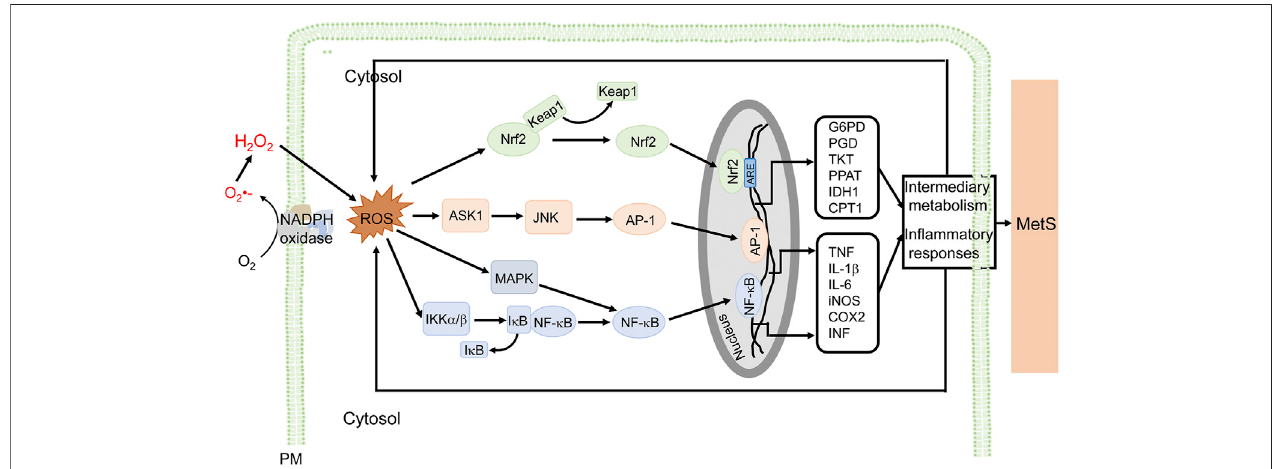
FIGURE 3 | NADPH oxidase-derived ROS signaling and cellular effects in MetS. ROS derived from NADPH oxidases are involved in the in fl ammatory responses associated with MetS, in macrophages, for example. ROS stimulate NF- κ B, via MAPK and IKK α / β , and AP-1, via ASK1 and JNK, which promote the transcription of proin fl ammatorygenes(e.g.,TNF,IL-1 β ,IL-6,iNOS,COX2,andINF),resultinginin fl ammatory responsesassociatedwithMetS.ROSalsoactivateNrf2toinducegenes that regulate intermediary metabolism (e.g., G6PD, PGD, TKT, PPAT, IDH1, and CPT1) (only some genes are listed). The antioxidant effect and modulation of metabolism are adaptive responses to ROS-induced proin fl ammatory responses and altered metabolism. ROS exert a wide range of effects such as in fl ammation, insulin resistance, adipocyte proliferation, altered metabolism, among others in diverse cells, including macrophages, endothelial cells, vascular cells, adipocytes, preadipocytes, and epithelial cells. The ROS-mediated signaling and cellular efforts are cell type-speci fi c that are overlapping. For simplicity and clarity, only part of signaling and cellular effects in macrophages are illustrated. AP-1, activator protein 1; ASK1, apoptosis signal-regulating kinase 1; COX2, cyclooxygenase-2; CPT1, carnitine palmitoyltransferase 1; G6PD, glucose-6-phosphate dehydrogenase; IDH1, isocitrate dehydrogenase 1; IL, interleukin; iNOS, inducible nitric oxide synthase; JNK,c-JunN-terminalkinases;Keap1,Kelch-likeECH-associatedprotein1;IKK,I κ Bkinase;MAPK,mitogen-activatedproteinkinase;MetS,metabolicsyndrome;PM, plasma membrane and other cellular membranes; NF- κ B, nuclear factor kappa-light-chain-enhancer of activated B cells; Nrf2, nuclear factor-erythroid 2 p45-related factor 2; PGD, 6-phosphogluconate dehydrogenase; PPAT, phosphoribosyl pyrophosphate aminotransferase; TKT,